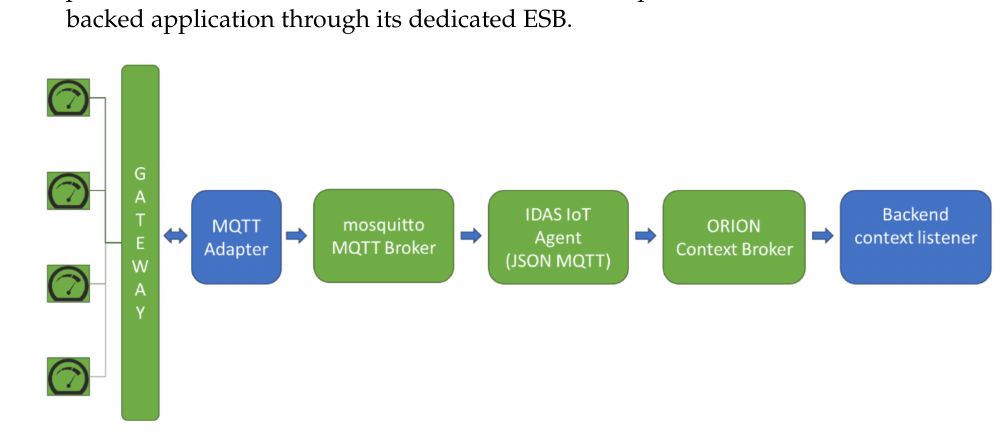
Figure 2. Data Acquisition Architecture based on FIWARE